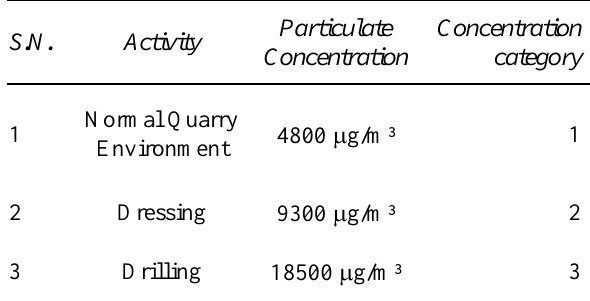
Table 3: Age wise distribution of workers